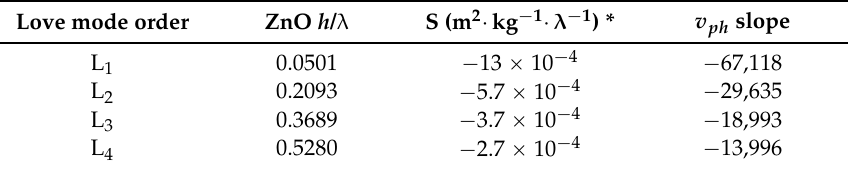
Table 1. Love mode orders, ZnO normalized thickness, gravimetric sensitivity values and the phase velocity slope: the data refer to modes travelling at the same velocity (9318 m/s).